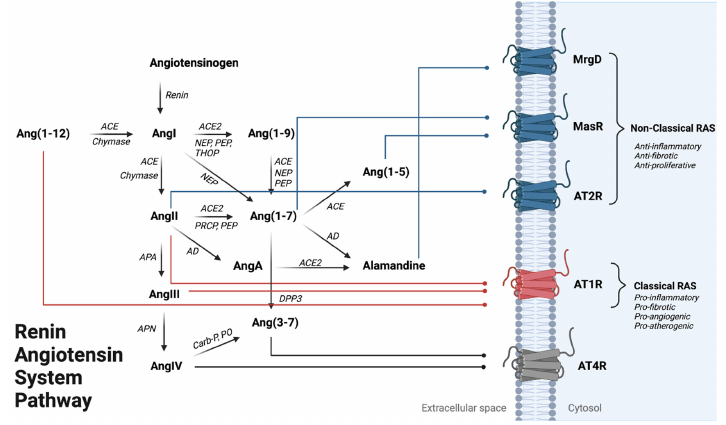
Figure 1. Renin–Angiotensin System Pathway Overview. Angiotensinogen is the penultimate RAS precursor that is cleaved by renin to form Angiotensin I (AngI). Alternatively, AngI can also be formed through chymase-mediated metabolism converting Ang(1-12) to AngI. AngI can be metabolized to Angiotensin II (AngII) through angiotensin-converting enzyme (ACE) or chymase-mediated metabolism, where AngII binding onto AT1R promotes the classical arm of RAS leading to vasoconstriction, inflammation activation, and cardiac hypertrophy. AngII can be further metabolized to form Angiotensin III (AngIII) by APA (aminopeptidase A), where AngIII metabolism via APN (aminopeptidase N) can form Angiotensin IV (AngIV), an AT4R agonist. Alternatively, AngII can form through NEP (neprilysin), PEP (prolyl endo-peptidase), and THOP (thimet oligopeptidase) mediated metabolism. Ang(1-7) is formed by (1) metabolism of AngII by ACE2, PEP, or PRCP (pro-X carboxypeptidase) or (2) an alternative pathway where Ang(1-9) can be metabolized by ACE, NEP, and PEP activity. Ang(1-7) can be metabolized to Ang(1-5) or Alamandine (AAng(1-7)) by ACE and AD (aspartate decarboxylase), respectively. AAng(1-7) can also be formed through AngII breakdown into AngA via AD, followed by AngA metabolism via ACE2. Ang(1-7) and Ang(1-5) can both bind onto MasR to counteract AT1R activation. AAng(1-7) binding onto MrgD, a Mas-related GPCR, can lead to vasodilation in the heart and kidney. Ang(3-7) can be formed by either (1) cleavage of AngIV by carboxypeptidase P (Carb-P) and prolyl oligopeptidase (PO) or by (2) dipeptidyl peptidase 3 (DPP3) cleavage of Ang(1-7). Red lines show the three RAS peptides that can being onto AT1R to activate the classical RAS pathway. Blue lines indicate peptide binding to anti-inflammatory signaling receptors AT2R, MasR, MrgD). Gray lines represent peptide binding onto the AT4R; the effects of this activation are currently not well